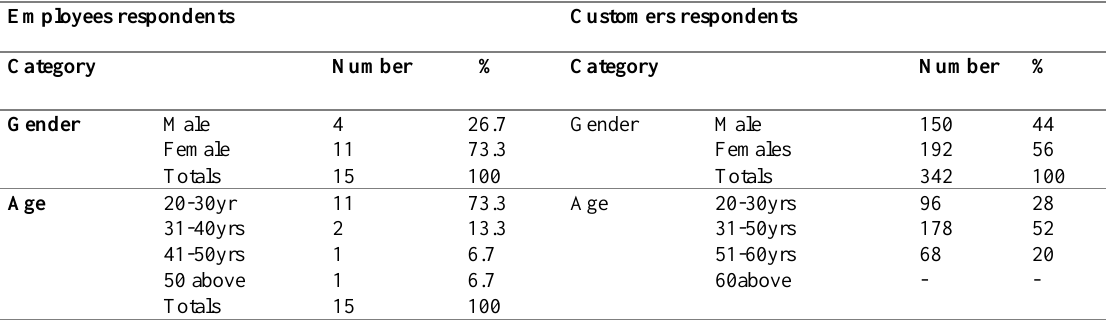
Table 1: Demographic Profiles of